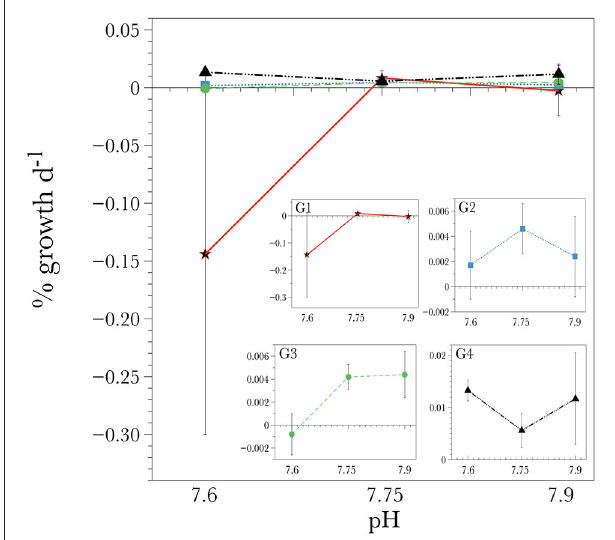
FIGURE 1 | Short-term calcification response of individual genotypes of L. pertusa corals in the different ocean acidification conditions. G1 through G4 refers to each genotype. Values are given as mean ± S.D